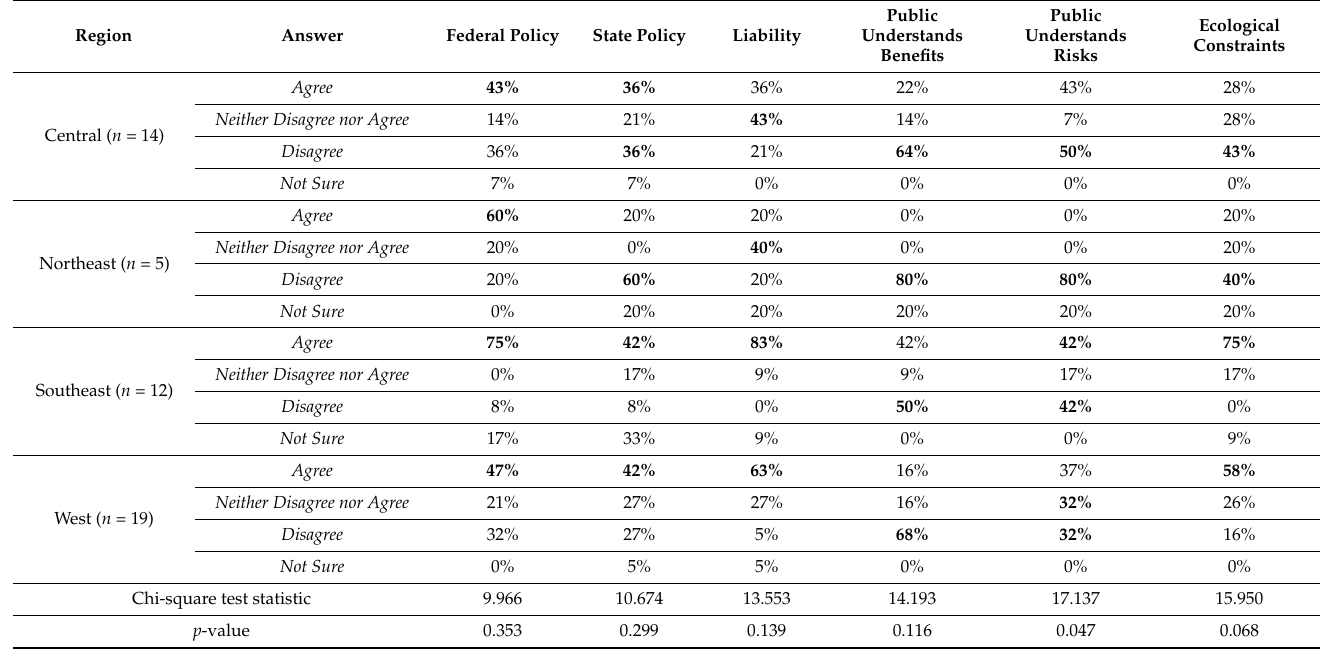
Table 1. Survey respondents’ perceived constraints of assisting private landowners with prescribed fire application at a regional scale. Chi-square test p -values for regional effect noted in the bottom row. The largest value in each column for each region are